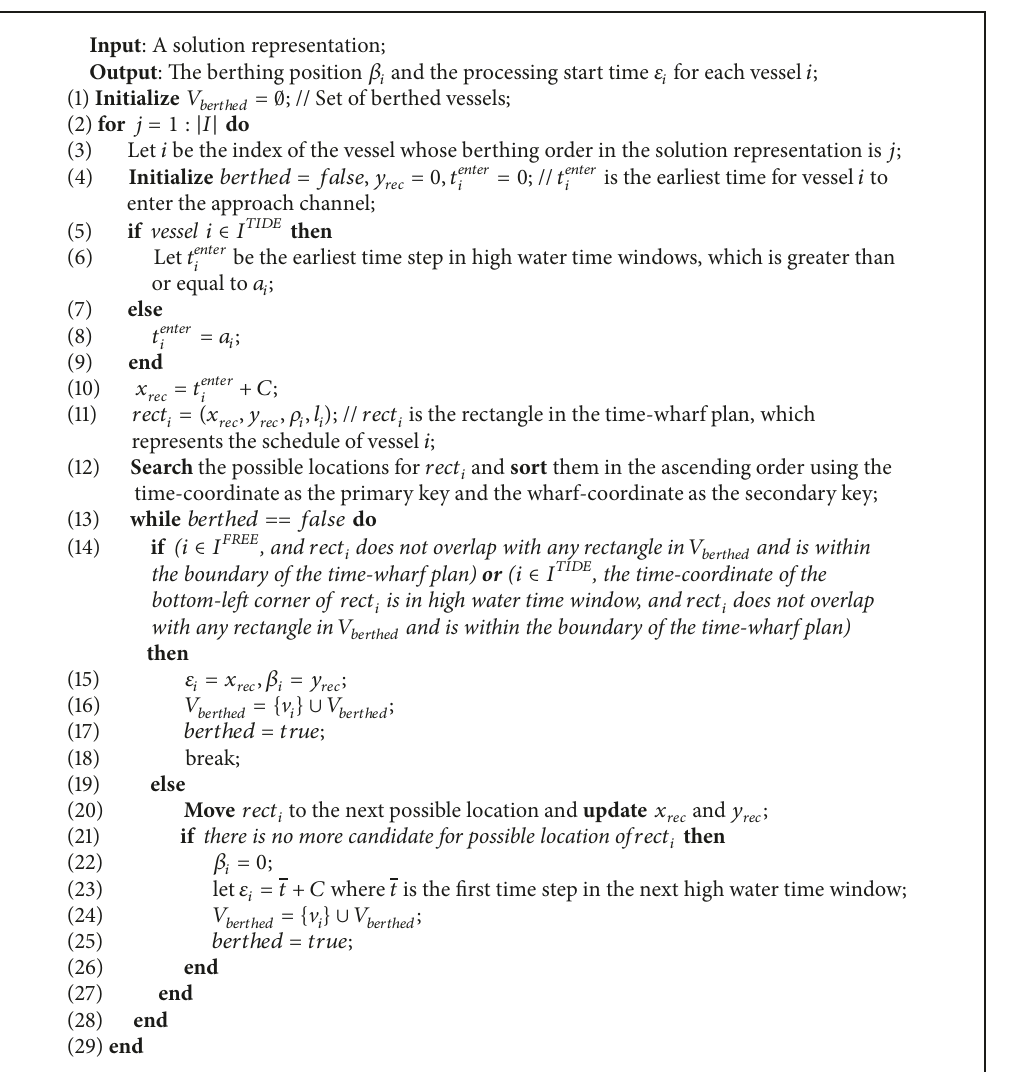
Algorithm 1: The greedy heuristic for